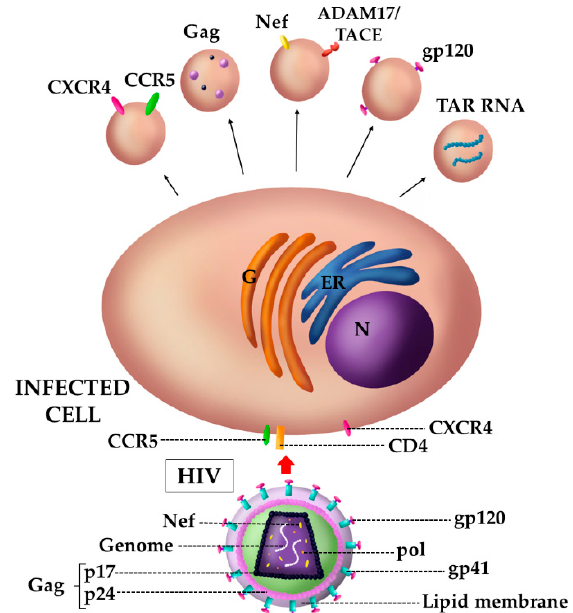
Figure 2. Schematic representation of EVs released by HIV-infected cells. EVs derived from HIV-infected cells carry both viral and host cell components that favor viral spreading and HIV-associated immune pathogenesis. Regarding host proteins, EVs transfer the two co-receptors CCR5 and CXCR4, used by the virus to mediate its entry, to null cells. Among viral components, EVs carry the proteins Gag, gp120 and Nef, as well as Trans-Activation Response (TAR) RNA, a pre-microRNA that produces mature microRNAs. Nef protein also induces the uploading into EVs of ADAM17 / TACE, a TNF α converting enzyme. Nucleus (N); endoplasmic reticulum (ER); Golgi complex (G).